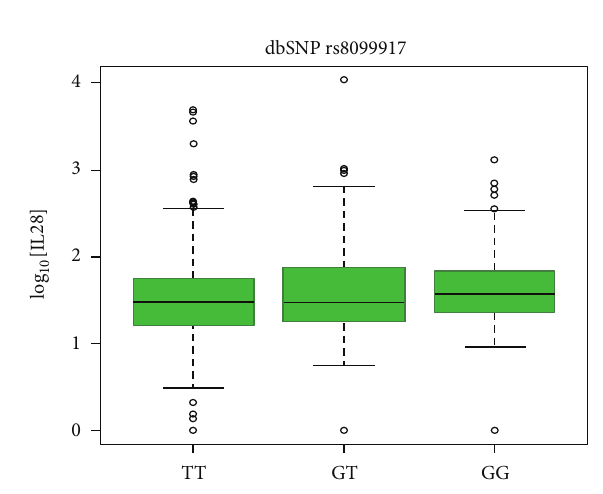
Figure 1: Boxplot analysis of rs8099917 genotypes against average serum IL28B concentration.